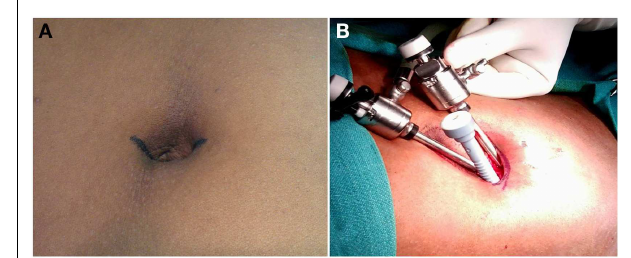
FIGURE 2 | Our technique of multiport single incision laparoscopy, where the similar type of incision is made to identify the umbilical cicatrix for placement of the ports .